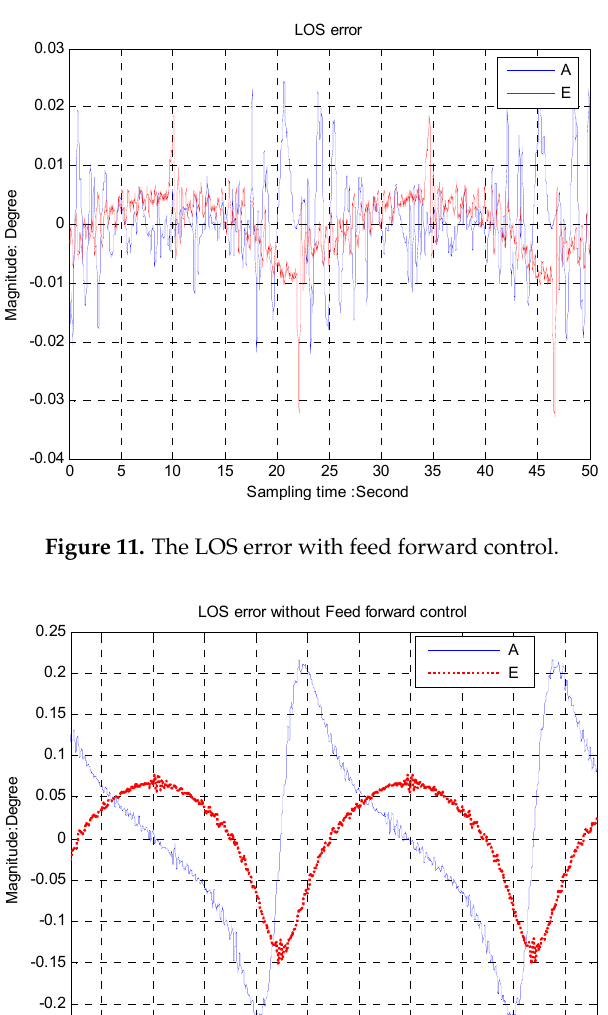
Figure 10. Elevation axis: target velocity and acceleration.